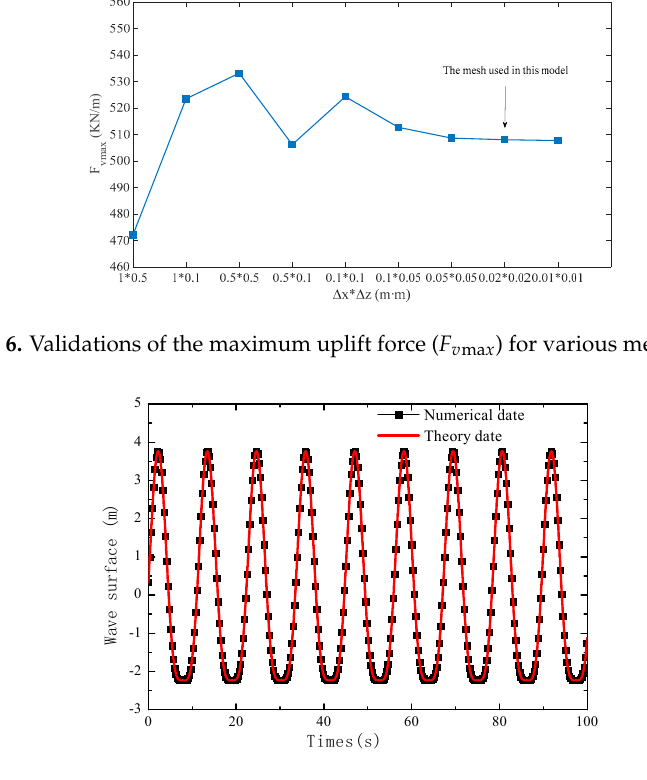
Figure 7. Comparison of the wave profile between numerical date and experimental date.